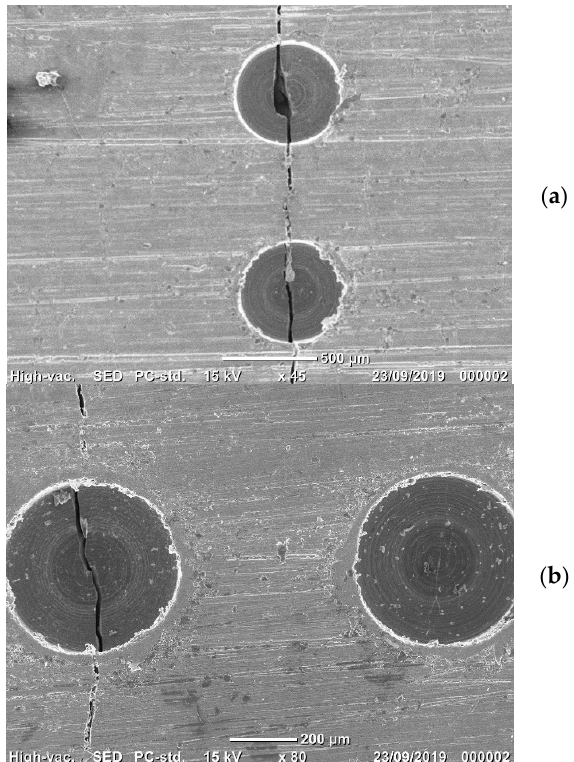
Figure 11. ( a ) Crack initiation and propagation for two transverse pits; ( b ) crack initiation and propagation for two longitudinal pits.